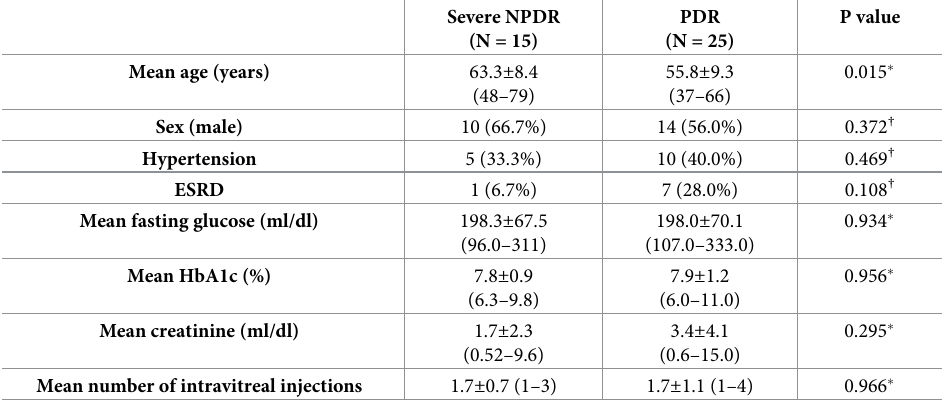
Table 2. Comparison between patients with severe nonproliferative diabetic retinopathy (NPDR) versus those with proliferative diabetic retinopathy